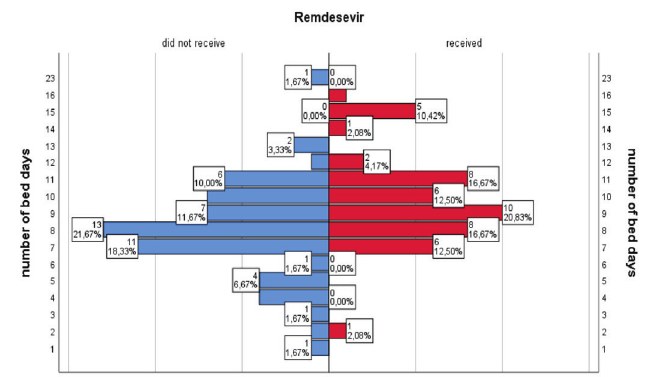
Figure 2 - Number of hospital bed days for pregnant women with coronavirus infection COVID - 19